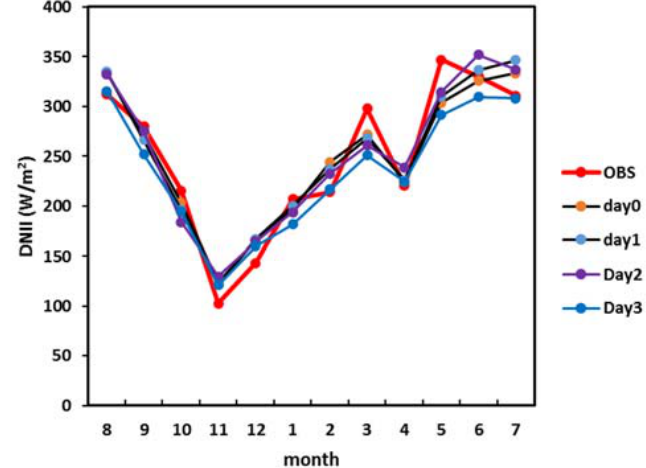
Figure 6. Monthly mean of predicted and observed daily mean DNI in Évora for the four different forecast days in the period from August 2018 to July 2019.